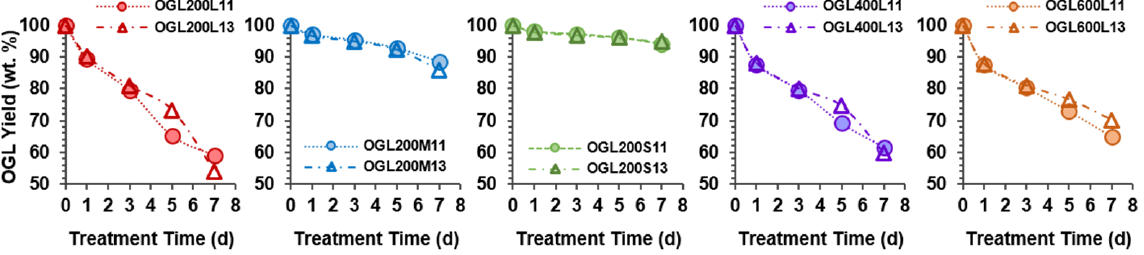
Figure 2. OGLs yields as a function of H 2 O 2 treatment time.